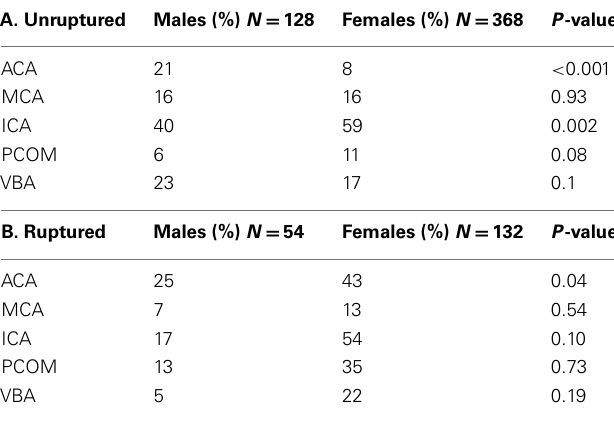
Table 3 | Distribution of gender, age, size, and anatomical location of ruptured and unruptured aneurysms.